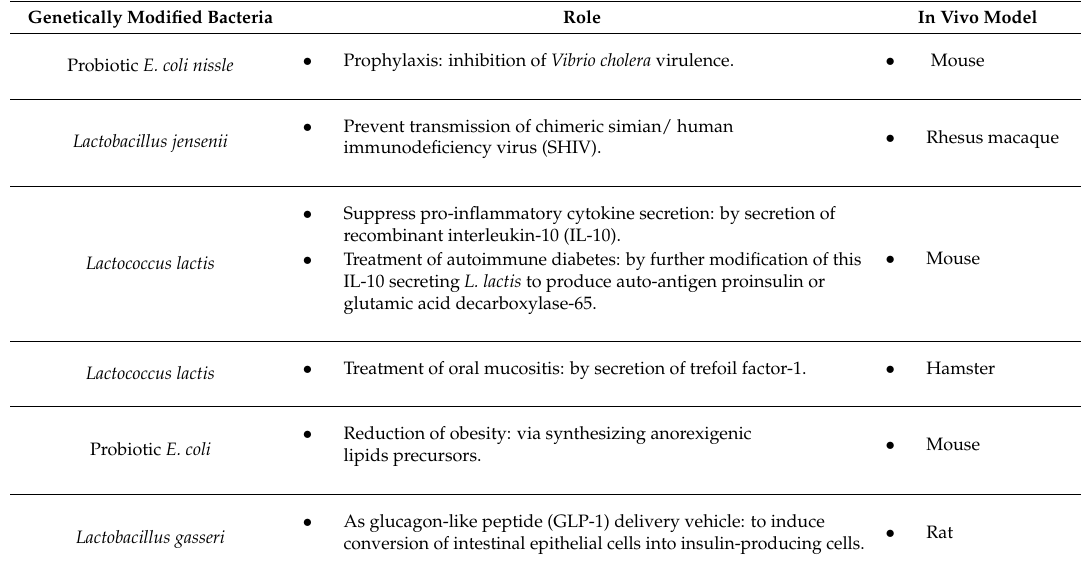
Table 2. Genetically-engineered normal bacterial flora and their possible therapeutic applications. Genetically Modified Bacteria